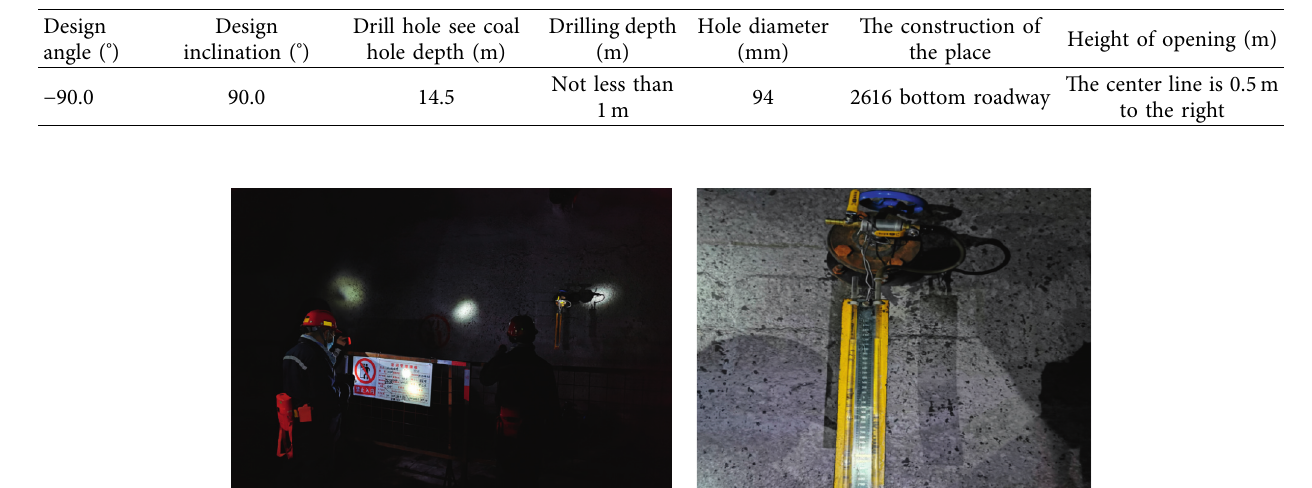
Figure 10: Site construction.